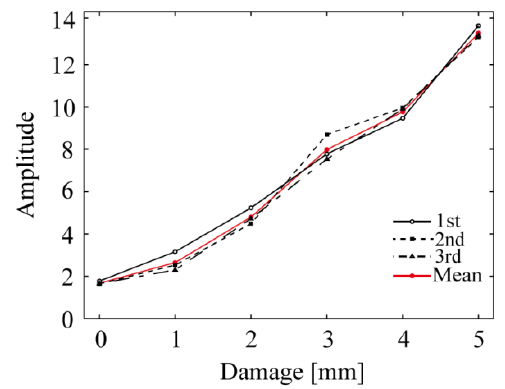
Figure 9. Damage assessment: tendency of normalized amplitudes of reconstructed input signal versus damage size.